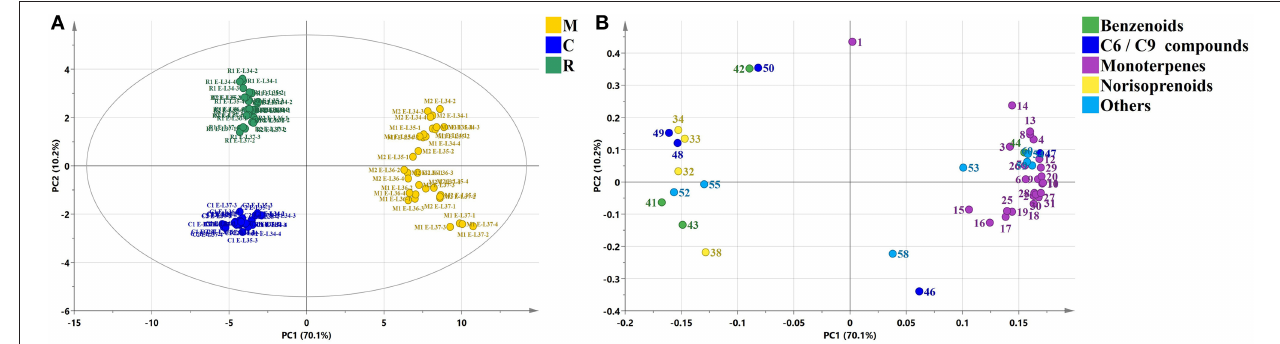
FIGURE 5 | Principal component analysis (A) and component loading plot (B) of glycosidic aroma compounds from three grape varieties (two clones of each). The marks in plot (A) refer to the statement shown in Figure 3 . The numbers in plot (B) correspond to compounds mentioned in Table 1 , Supplementary Tables 2 , 3 , Figures 1 , 6